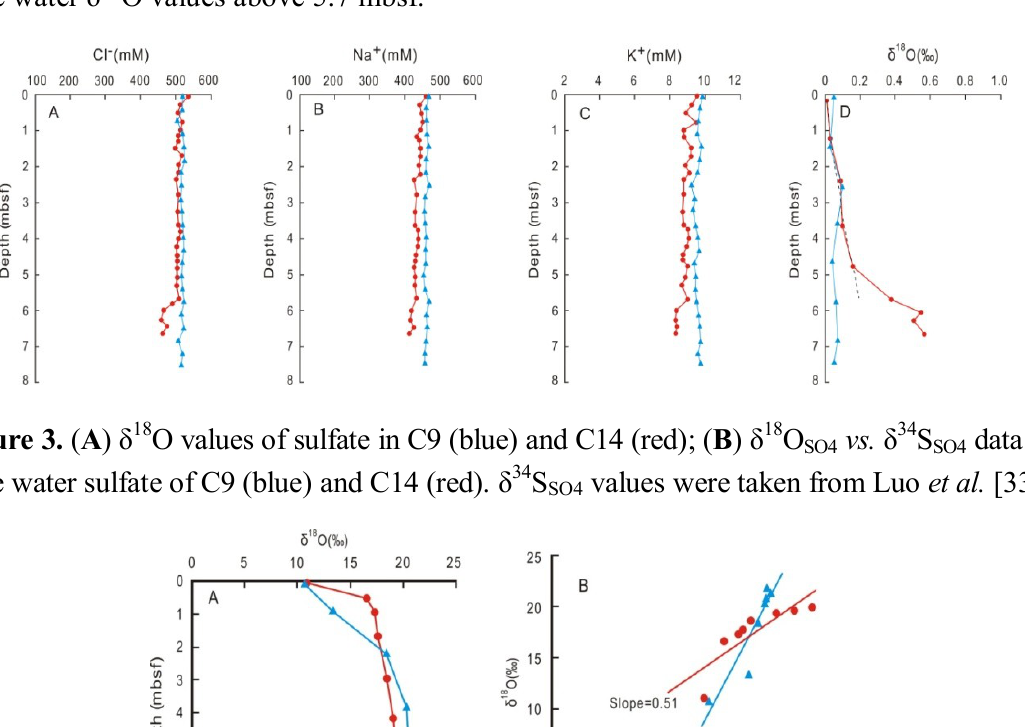
Figure 2. Pore-water concentration profiles of Cl − ( A ), Na + ( B ), and K + ( C ) as well as δ 18 O values ( D ) for C9 (blue) and C14 (red). The dash line in ( D ) representing the background trend of δ 18 O values is determined via polynomial fitting using measured pore water δ 18 O values above 5.7 mbsf.